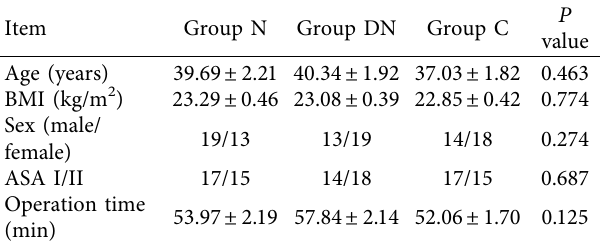
Figure 1: Flowchart showing details of clinical procedures throughout the study. Table 1: Demographics of the participants who completed the